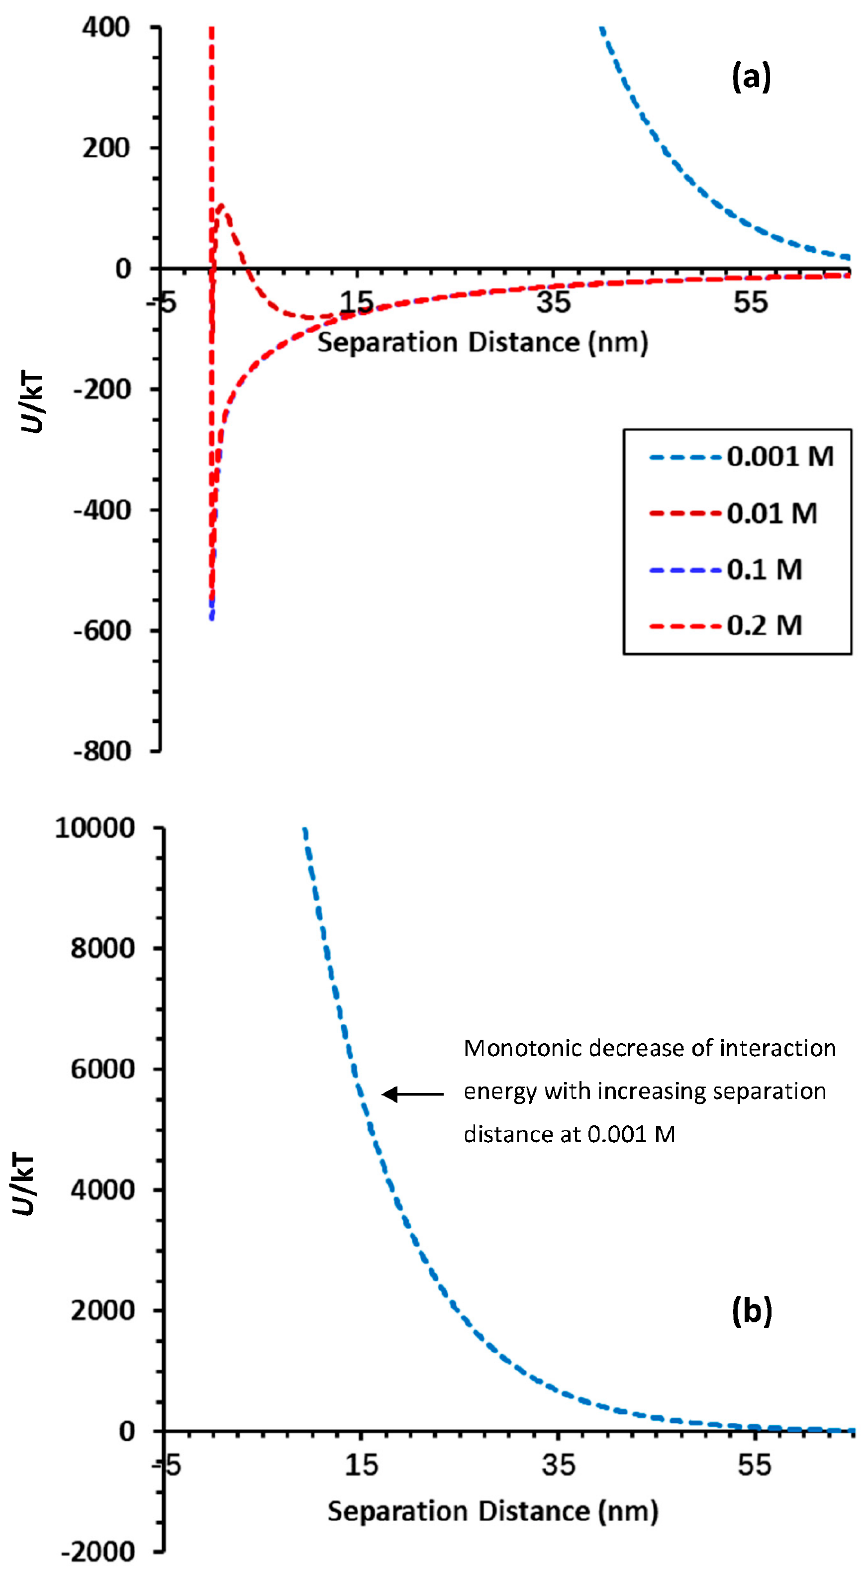
Figure 6. Calculated DLVO interaction energy profiles for a cuboid Mt (1.5 µ m × 1.5 µ m × 500 nm) loading with 20 nZVI particles interacting with a planar sand surface at different solution ISs; ( b ) is re-plotted profiles of ( a ) to highlight the monotonic decrease of interaction energy with increasing separation distance at 0.001 M.